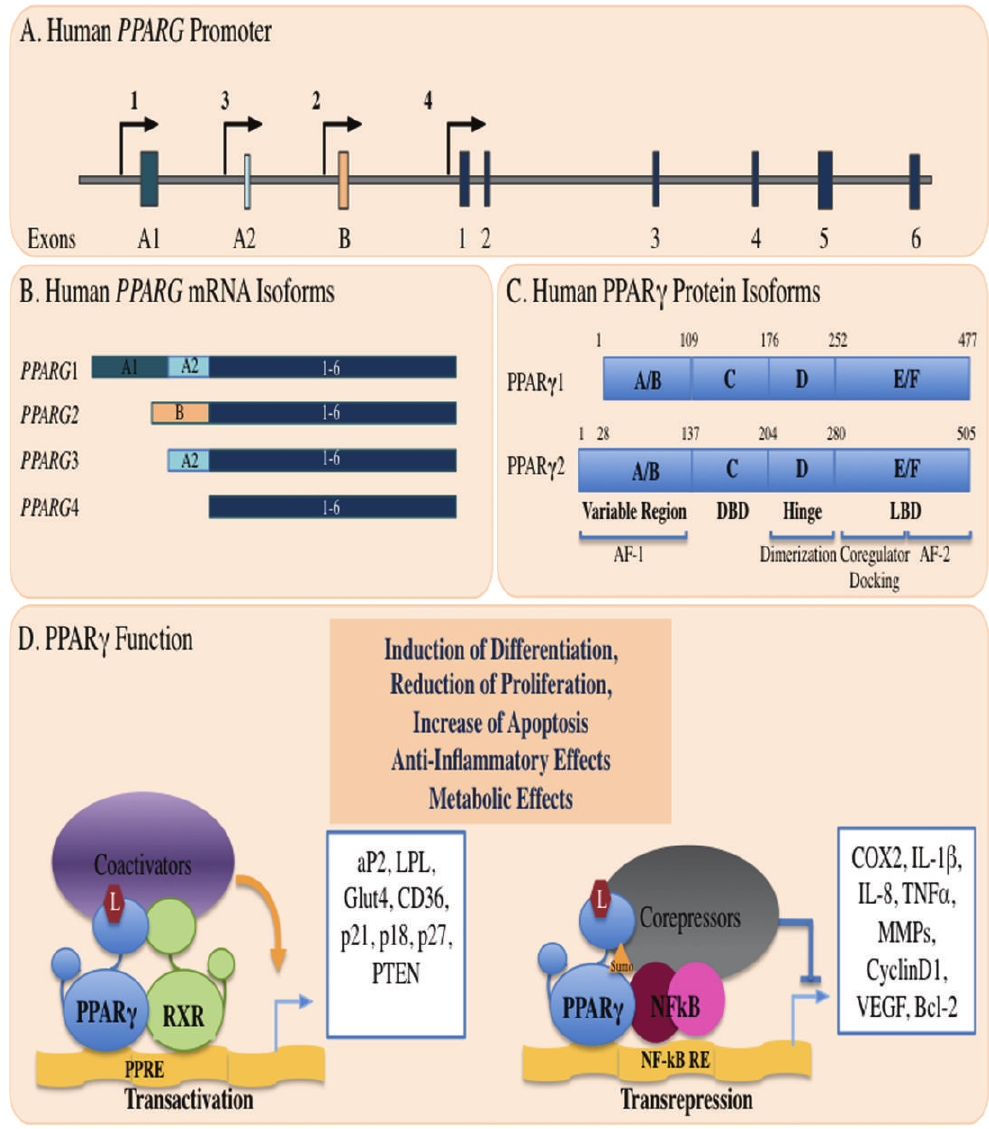
Figure 2: (a) PPARG schematic structure at chromosome 3p25. The arrows indicate the transcription start sites for each specific mRNA isoform; the boxes indicate the exons. (b) The four mature transcribed mRNAs are depicted. (c) The PPARG 1, 3, and 4 mRNA isoforms are translated into the unique PPAR γ 1 protein; the PPARG 2 transcript is translated into PPAR γ 2, containing 28 additional amino acids at its N-terminal region. The four functional domains of the mature protein are reported. (d) PPAR γ mechanisms of action. Transactivation: in the presence of ligands, PPAR γ binds the cognate PPRE as heterodimer with RXR and activates gene expression. Transrepression: in the presence of ligands, the SUMOylated form of the receptor interacts with others transcription factors, such as NF κ B, and represses their target genes transcription, adapted from reference